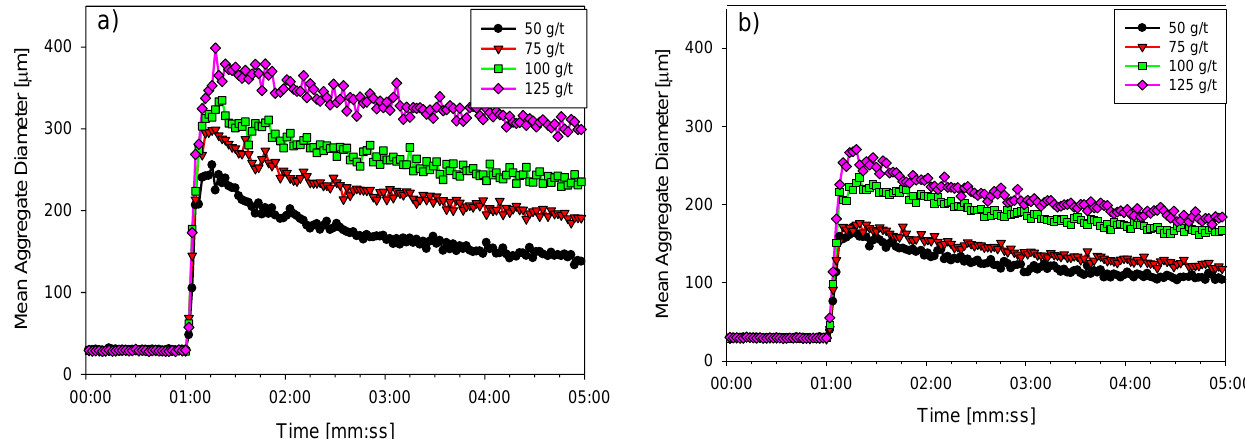
Figure 6. Effect of the flocculant dose on the evolution of the average size of kaolin aggregates in IW ( a ) and SW ( b ). Mixing rate 180 rpm, solids concentration 5 wt%, and pH 7.